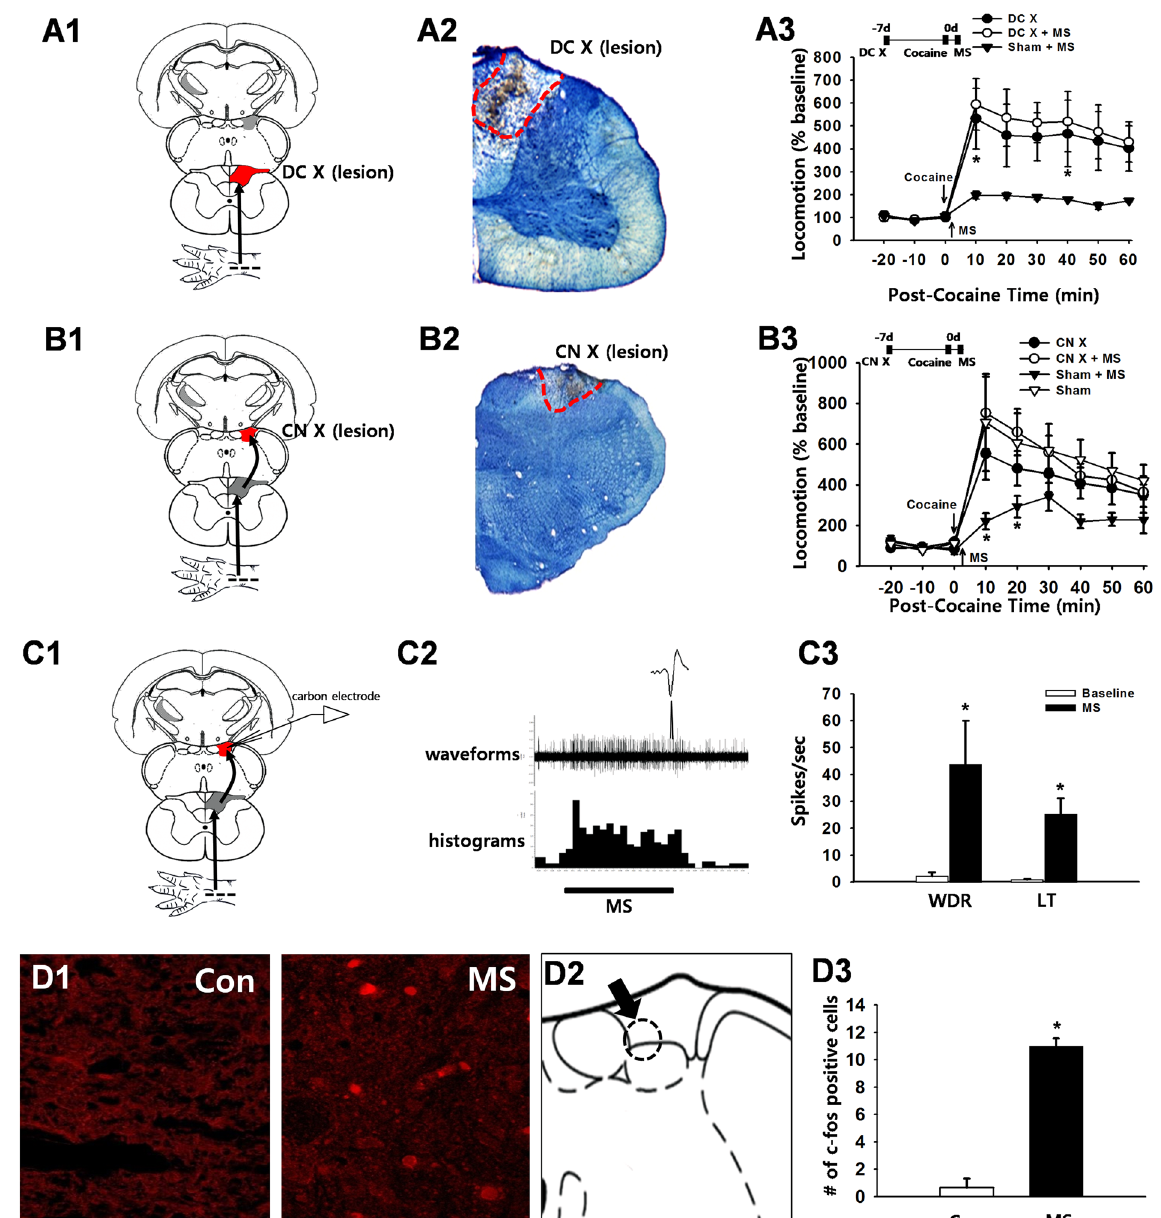
Figure 2. The role of the dorsal column somatosensory pathway in ulnar nerve inhibition of cocaine-induced locomotion. ( A ) Dorsal column lesions (DC X) were introduced bilaterally at the C3 level of the spinal cord (A1), as shown in a representative image of toluidine blue staining (A2). Mechanical stimulation (MS) of the ulnar site (MS) reduced cocaine-induced locomotion (Sham + MS; n = 10), compared to the control group (DC X; n = 6), which was blocked by surgical lesion of DC prior to MS (DC X + MS; n = 7; A3). * p < 0.05 vs. Sham + MS. ( B ) When CN lesions (CN X) were performed bilaterally 7–10 days prior to the experiment (B1 and B2), MS of the ulnar site failed to reduce cocaine locomotion (CN X + MS; n = 10), compared to the control groups of CN X (CN X; n = 5), Sham ( n = 5) and Sham + MS ( n = 5; B3). * p < 0.05 vs. CN X + MS. ( C ) Representative waveforms and peri-stimulus time histograms of in vivo extracellular recordings in CN neurons (C1–2). Ulnar MS markedly increased CN WDR ( n = 6) and LT ( n = 7) spiking activity (C3). * p < 0.05 vs. Baseline. ( D ) Increased expression of c-fos immunopositive cells following ulnar stimulation (MS, n = 6; D1 & D3) in the dorsomedial portion of the CN (D2), compared to the control group (Con, n = 6; D1). Bar = 20 µ m. * p < 0.05 vs. Con